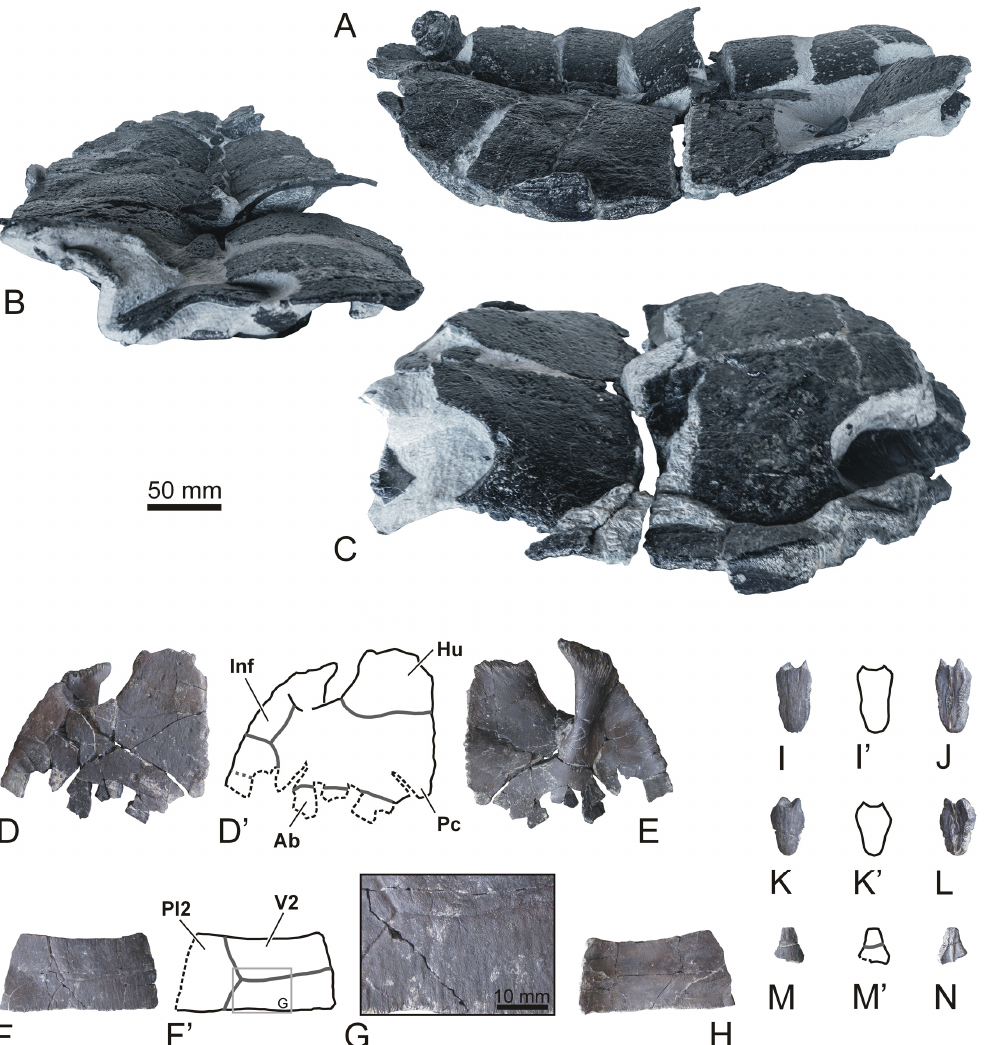
Figure 3. Specimens of the thalassochelydian turtle Hylaeochelys kappa from the middle to late Tithonian Freixial Formation of two outcrops in the Torres Vedras Municipality (Lisbon District, Lusitanian Basin, west-central Portugal). A–C, specimen SHN 025, a partial and articulated shell from Porto Chão Beach (Cambelas, São Pedro da Cadeira Civil Parish). A–B, carapace in right lateral (A) and anterior (B) views. C, plastron in left lateral view. D–N, selection of elements of the specimen SHN 026, a partial and disjointed shell from Zibreira (Carvoeira Civil Parish). D–E, right hyoplastron, in ventral (D–D’) and dorsal I views. F–H, partial left third costal, in dorsal (F–F’) and ventral (H) views, and detail of the ornamentation of its outer surface (G). I–N, three neurals, in dorsal (I, I’, K, K’, M, M’) and ventral (J, L, N) views. Dotted lines in D’, F’, I’, K’ and M’ indicate broken edges, continuous black lines correspond to the margins of the plates, and the border of the scutes are represented by thicker gray lines. The scale bar applies to the entire figure except to G.